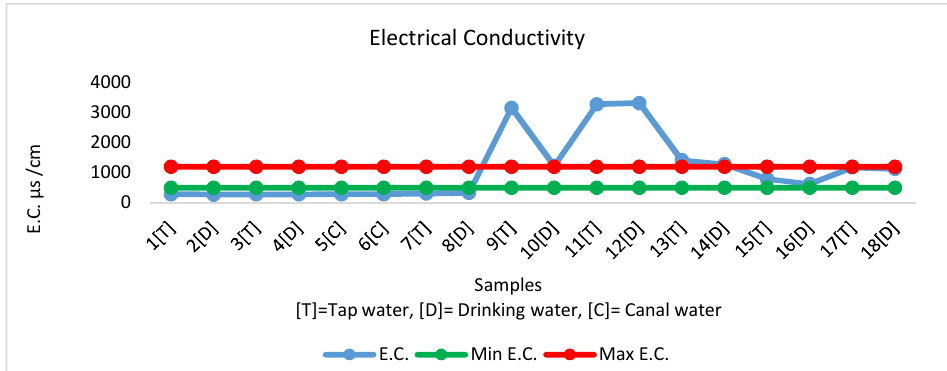
Fig. 8: Electrical Conductivity results of 18 samples taken from 6 locations in Nawabshah